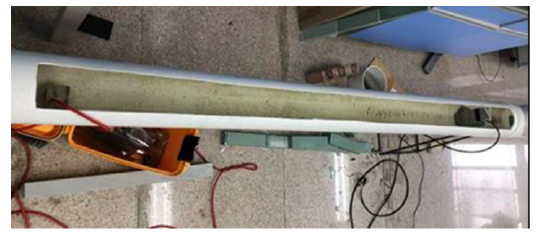
Figure 14. Experimental device. Figure 15 shows the comparison between the experimental and simulation results. Both the simulation and experiment investigated the case of a large Debye length. The red curve is the simulation result showing that the coupling coefficient of the streaming current changed with the salinity calculated using the method developed in this study. The blue dots are the peak values of the electric field signal measured under different salinities. It can be seen from the figure that with the increase in the salinity of pore fluid, the electrokinetic coupling coefficient obtained via the simulation increased first and then decreased; meanwhile, the peak value of the electric field caused by the seismoelectric effect of the rock samples increased first and then decreased, and the changing trend of the two with the salinity was basically consistent. It can be seen from Equation (32) that the streaming current coupling coefficient was proportional to the effective net residual charge density, and the effective net residual charge density first increased and then decreased with the increase in salinity (shown in Figure 12b). When the salinity was low, the Debye length was large. At this time, the effective net residual charge density increased with the increase in salinity. When the salinity increased to a certain extent, the electric double layer became thinner. In this situation, the shear potential of the electric double layer decreased and the effective net residual charge density decreased with the increase in salinity, leading to a decrease in the coupling coefficient. Therefore, the coupling coefficient of the streaming current first increased and then decreased with the increase in salinity.